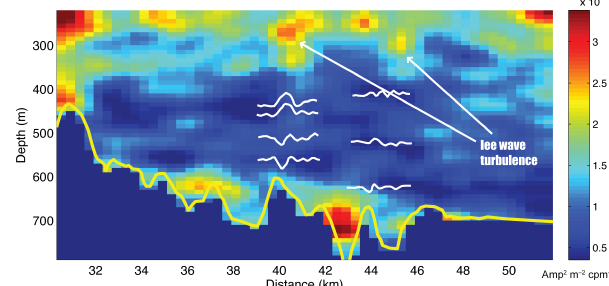
Figure 6. Map of seismic spectral energy in the turbulent subrange calculated via data transform. Here, the color-map does not show diffusivities. Instead, this map gives a qualitative view of relative turbulent energy across the section. White lines track the location of the lee wave features, traced from the seismic data.